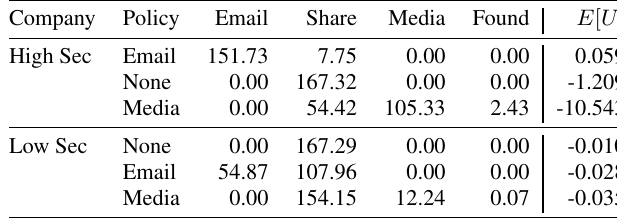
Table 2: Results from the document-sharing